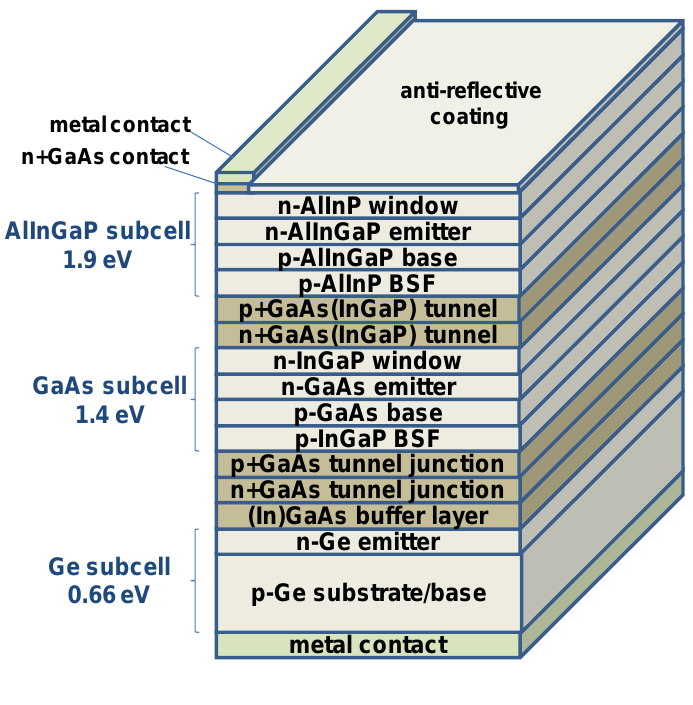
Figure 5. Cross-sectional schematic of a triple-junction cell structure.